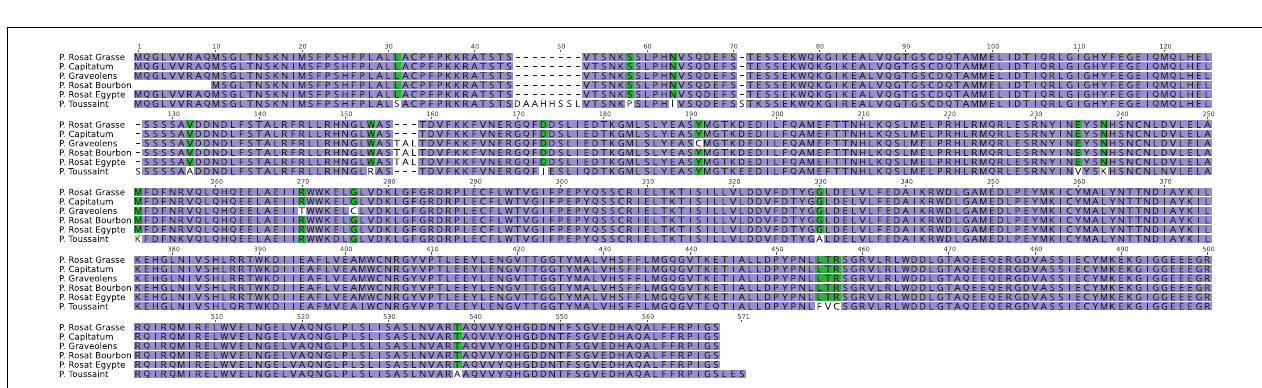
cycles, a melting-curve analysis (65 ◦ C to 95 ◦ C, one